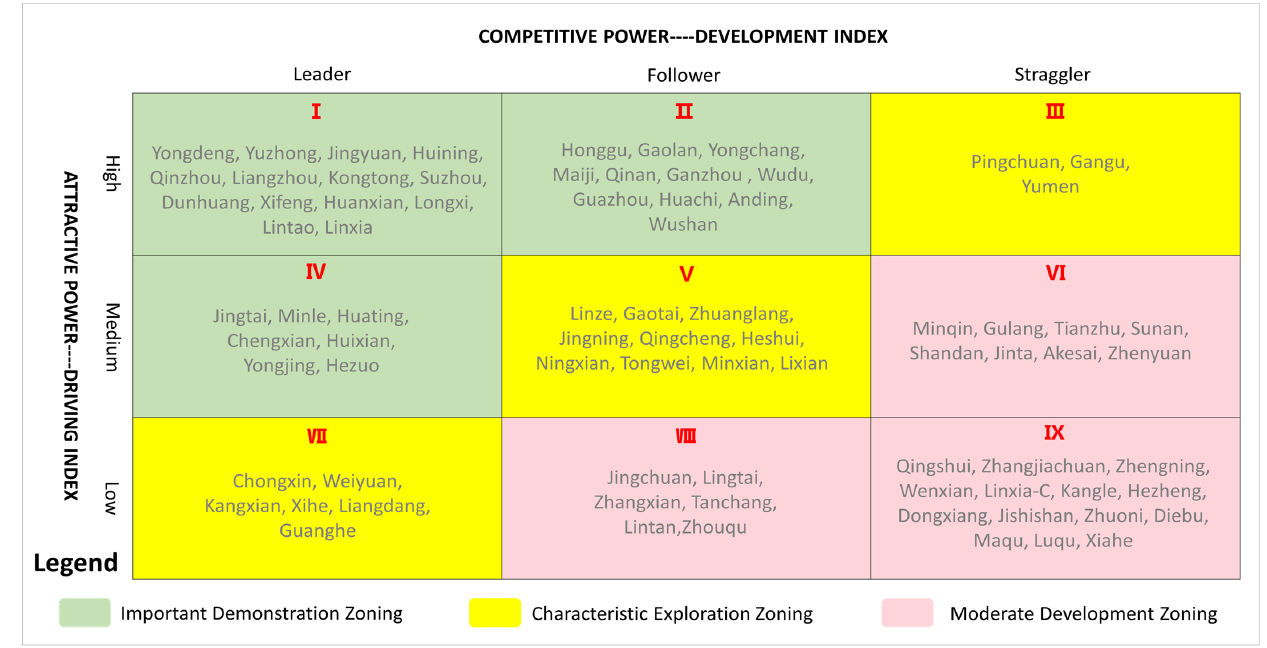
Figure 8. Analysis on spatial zoning of village digitalization in Gansu.